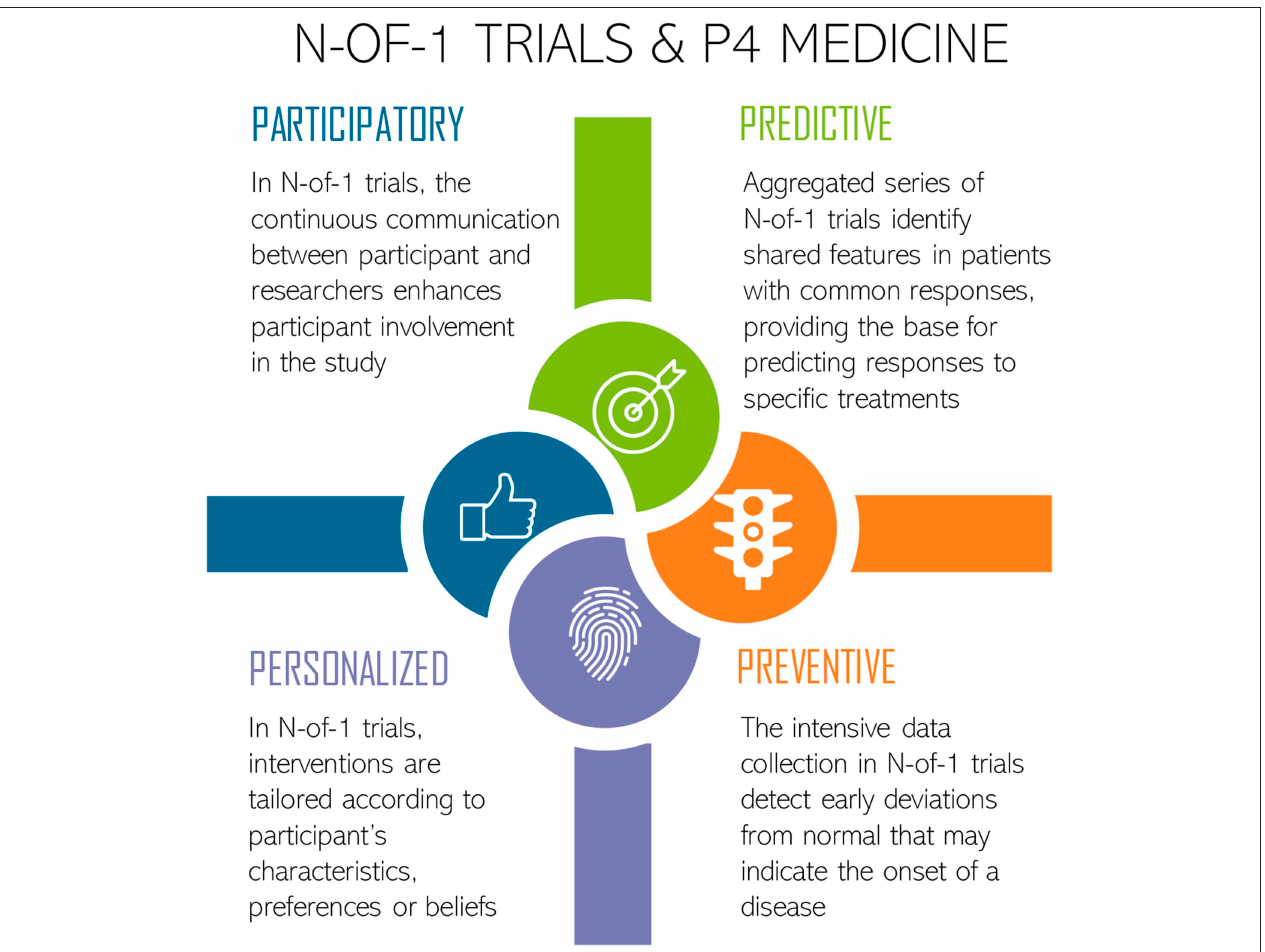
FIGURE 1 | N-of-1 trials approach for P4 Medicine: Predictive, Preventive, Personalized, and Participatory. Icons made by Freepik from www.flaticon.com.